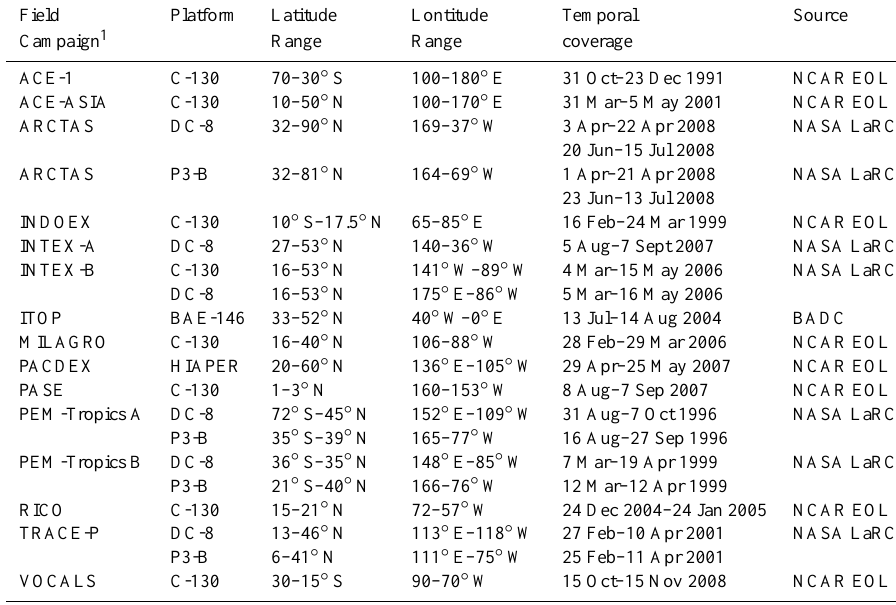
Table A1. List of observational data used in Sect. 5.2 for evaluating the simulated concentration of condensation nuclei. The measure- ment campaigns include: ACE-1 (Southern Hemisphere Marine Aerosol Characterization Experiment), ACE-ASIA (Asian Pacific Regional Aerosol Characterization Experiment), ARCTAS (Research of the Composition of the Troposphere from Aircraft and Satellites), INDOEX (Indian Ocean Experiment), INTEX-A (Intercontinental Chemical Transport Experiment – Phase A), INTEX-B (Intercontinental Chemical Transport Experiment – Phase B), ITOP (International Transport of Ozone and Precursors), PACDEX (PACific Dust EXperiment), RICO (Rain in Cumulus Over the Ocean), VOCALS (VAMOS Ocean Cloud Atmosphere Land Study), PASE (Pacific Atmospheric Sulfur Ex- periment), PEM-Tropics A (Pacific Exploratory Missions Tropics A), PEM-Tropics B (Pacific Exploratory Missions Tropics B), TRACE-P (TRAnsport and Chemical Evolution over the Pacific). The data are provided by the NASA LaRC Airborne Science Data for Atmospheric Composition program (NASA LaRC), National Center for Atmospheric Research Earth Observing Laboratory (NCAR EOL), and the British Atmospheric Data Centre (BADC). The aircraft trajectories are shown in Fig. 10.